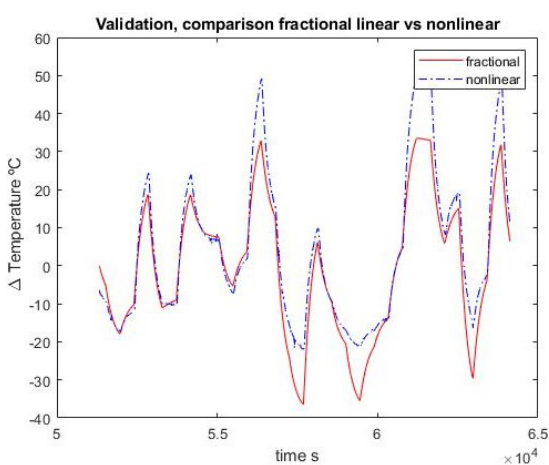
Figure 6. First-order linear ordinary model. Validation.